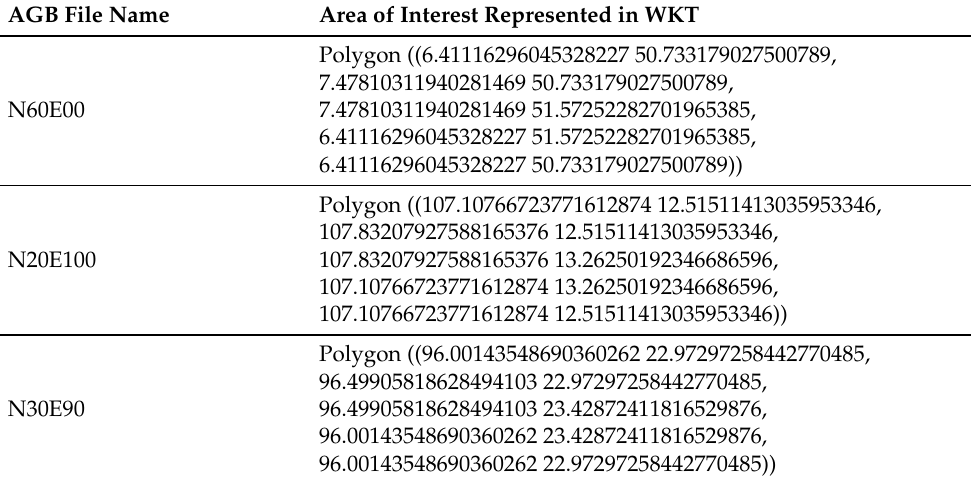
Table 1. List of the file names downloaded from the ESA Biomass Climate Change Initiative of the global above-ground forest biomass for 2018, v3, in Geotiff format containing AGB rasters. In each GeoTiff file, a study area was cut out and reported in well-known text (WKT) format. AGB File Name Area of Interest Represented in WKT